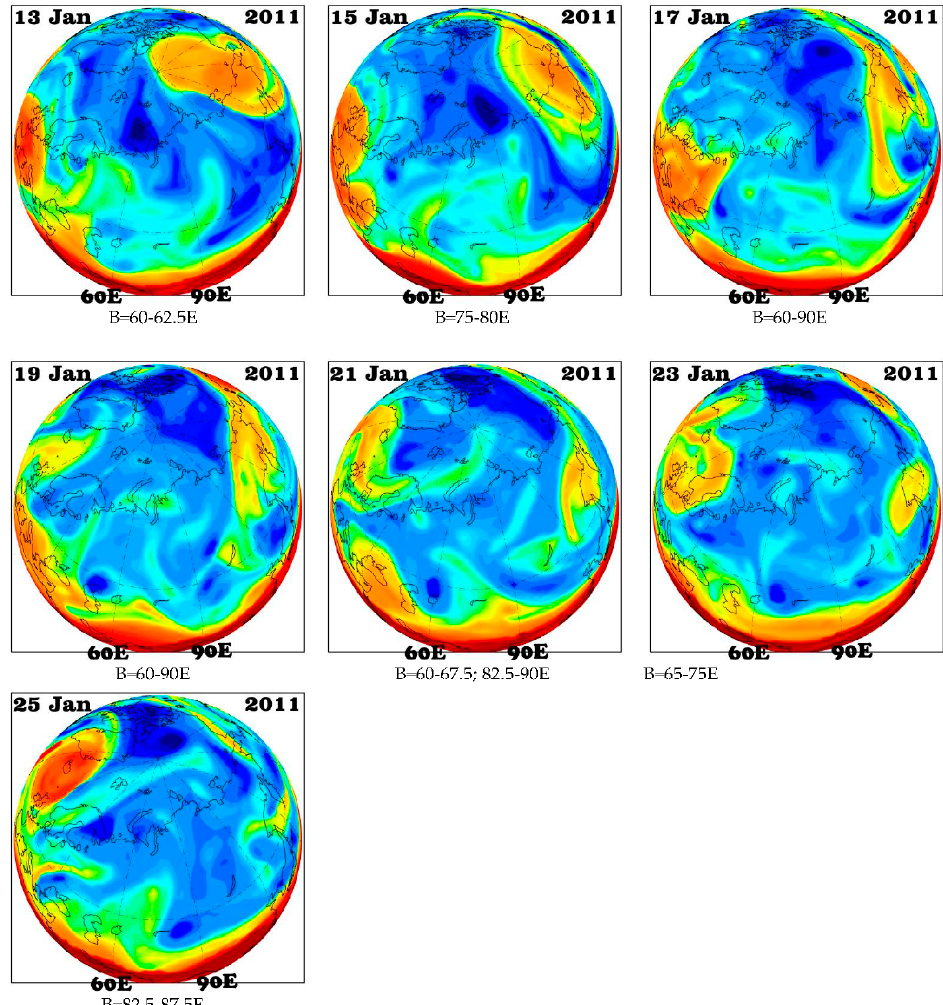
Figure 5. PV2- θ field for the second blocking event in 2010/2011, to which a “non-dipole” surface temperature anomaly distribution corresponds. The longitudes on which the blocking is identified are under each panel.